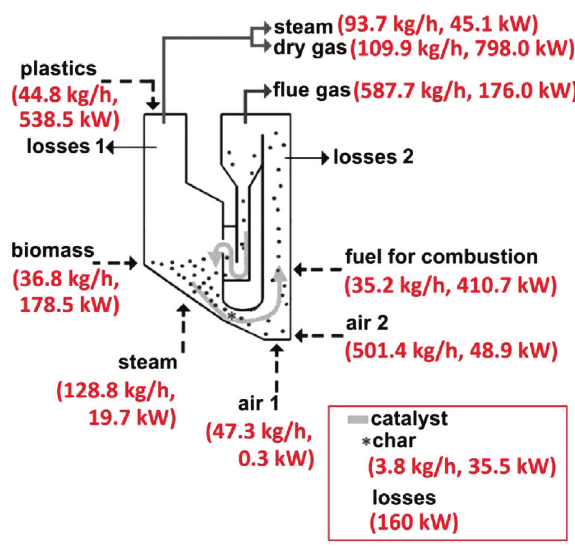
Fig. 3. Scale-up results obtained by taking pilot plant experiment as a basis. With 160 kW of losses the cold-gas efficiency amounts to